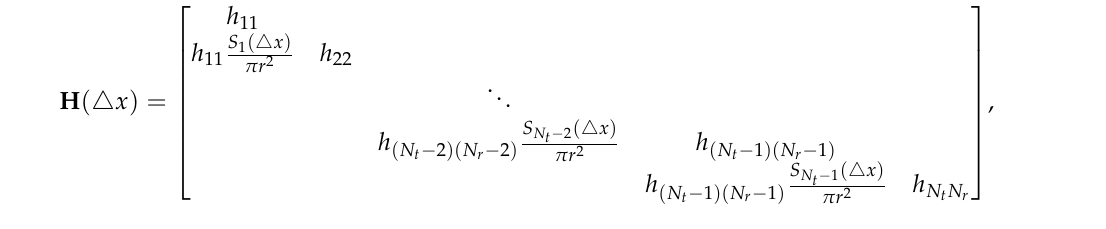
Figure 6. The conditions number of H versus the link misalignment error (cid:52) x . Through the imaging lens at the receiving end, the light beams from different LEDs are separated, and the elements on the diagonal of the channel matrix are much larger than those on the non-diagonal. At this time, the interference between different LED beams is mainly caused by spot mobility caused by link misalignment. Different directions of spot mobility will cause the detector to be interfered with by other spots. Taking Figure 3b as an example, the channel matrix can be represented as